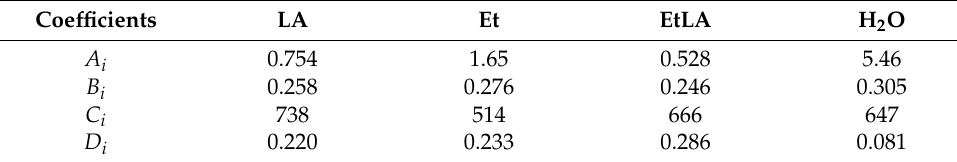
Table 3. Numerical values of the coefficients used to calculate the density of each component.